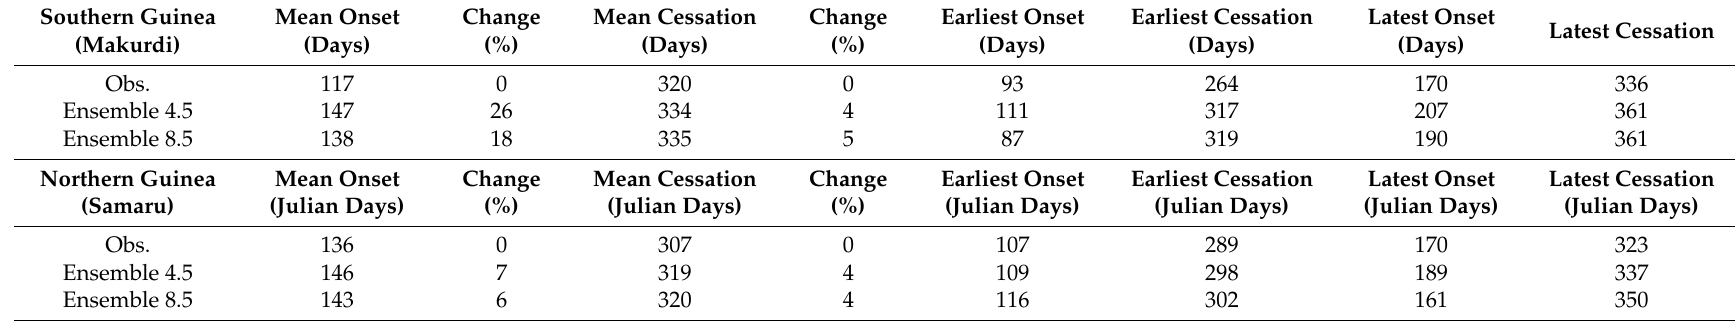
Table 5. Southern and Northern Guinea average ensemble change in the rainfall characteristic for the future period (2021/2025–2050) relative to the baseline (1976/1980–2005). All in Julian days.